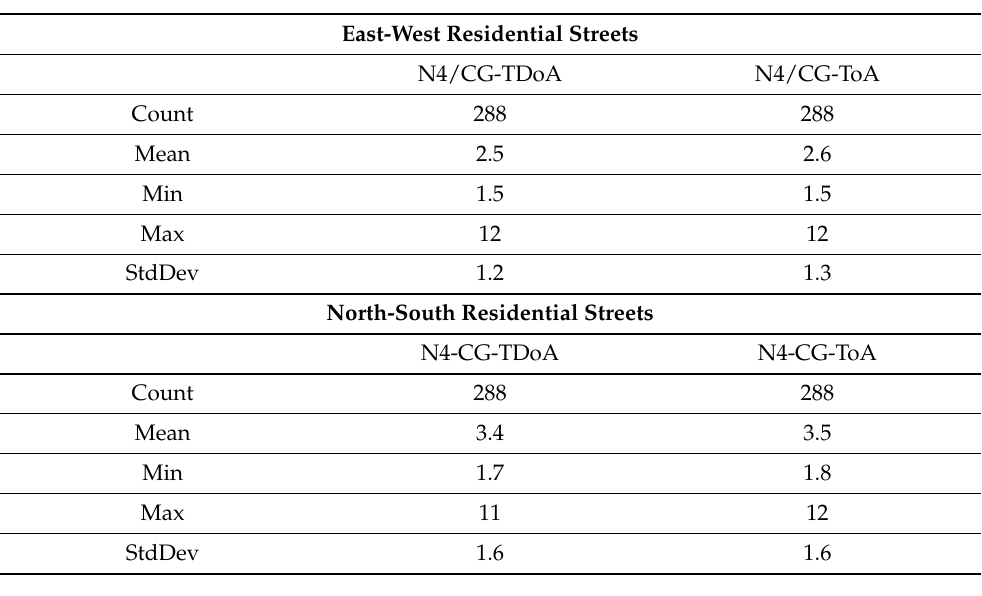
Table 9. Residential streets: statistical analysis of PDOP for GNSS and four mirrored 5G stations (N4) in TDoA (CG-TDoA) and ToA (CG-ToA)